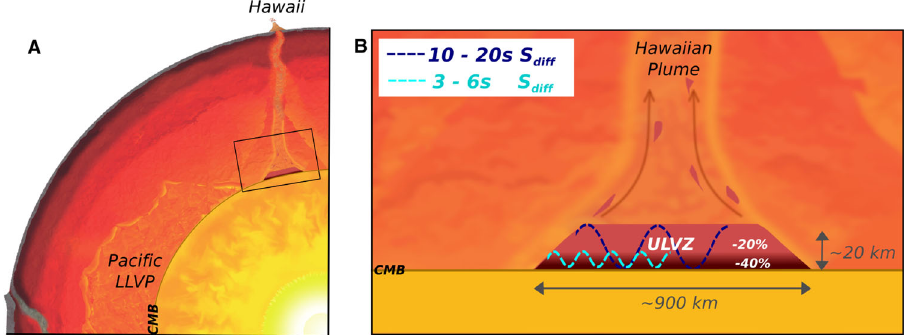
Fig. 5 Conceptual cartoons of the Hawaiian ultra-low velocity zone (ULVZ) structure. A ULVZ on the core – mantle boundary at the base of the Hawaiian plume (height is not to scale) ( B ) a zoom in of the modeled ULVZ structure, showing interpreted trapped postcursor waves (note that the waves analyzed have horizontal displacement).